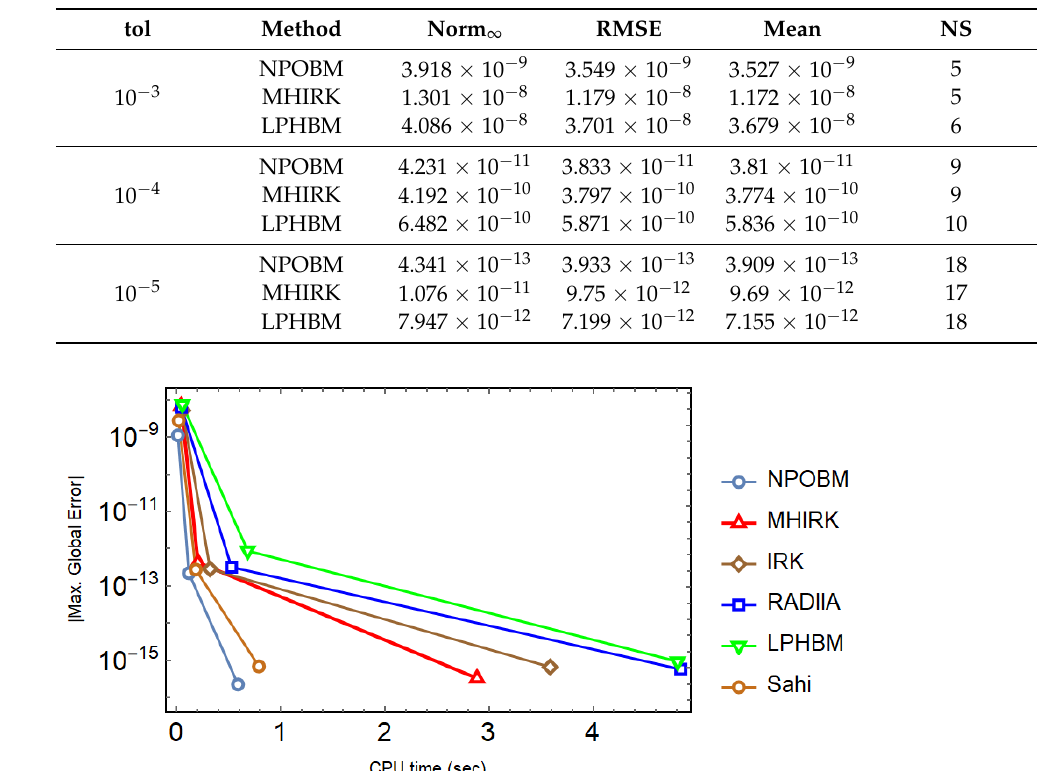
Table 8. Numerical results for Problem 2 with adaptive step-size approach while ∆ x ini = 10 − 6 .